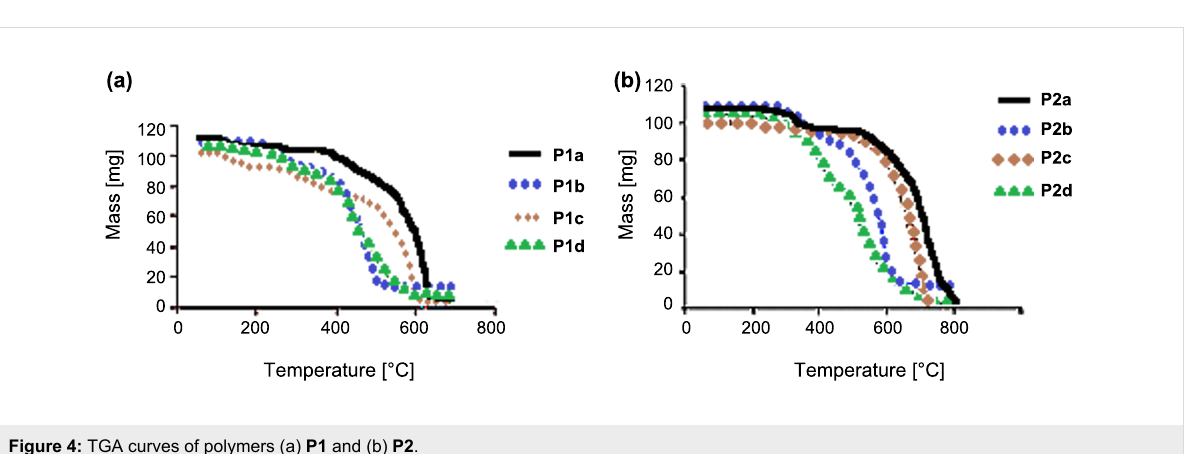
Figure 4: TGA curves of polymers (a) P1 and (b) P2 .